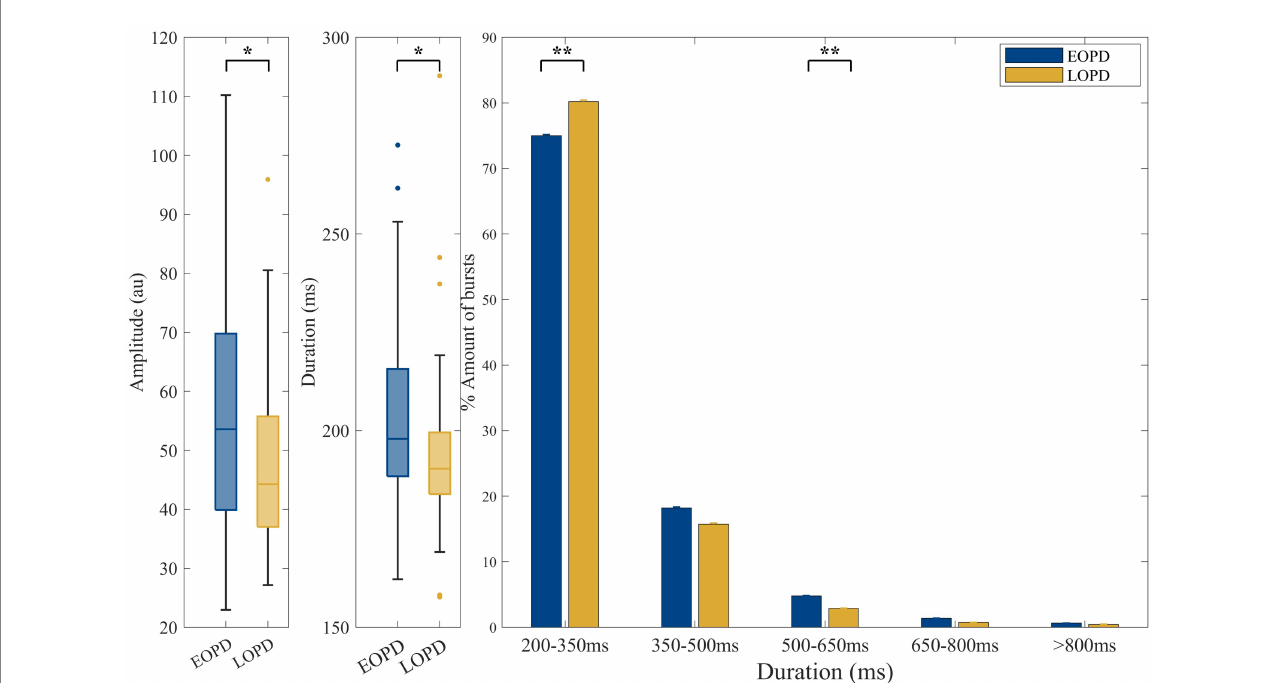
FIGURE 3 Comparison of low-beta burst between EOPD and LOPD. (A) The average low-beta burst power was significantly higher in EOPD (EOPD: 56.70 ± 20.10 au. LOPD: 47.27 ± 14.73 au, p = 0.016). (B) The average low-beta burst duration of EOPD was significantly longer than that of LOPD (EOPD: 203.74 ± 22.55 ms, LOPD: 193.79 ± 20.80 ms, p = 0.011). (C) Illustration of beta burst duration categorized into five time windows. The proportion of long burst (burst duration 500–650 ms) was significantly increased in EOPD when compared to LOPD (EOPD: 4.79% ± 3.86%, LOPD, 2.88% ± 2.87%, p = 0.008). In contrast, the proportion of short low-beta bursts (burst duration 200–350 ms) was significantly higher in LOPD when compared to EOPD (EOPD: 75.00% ± 10.52%, LOPD, 80.22% ± 10.79%, p =